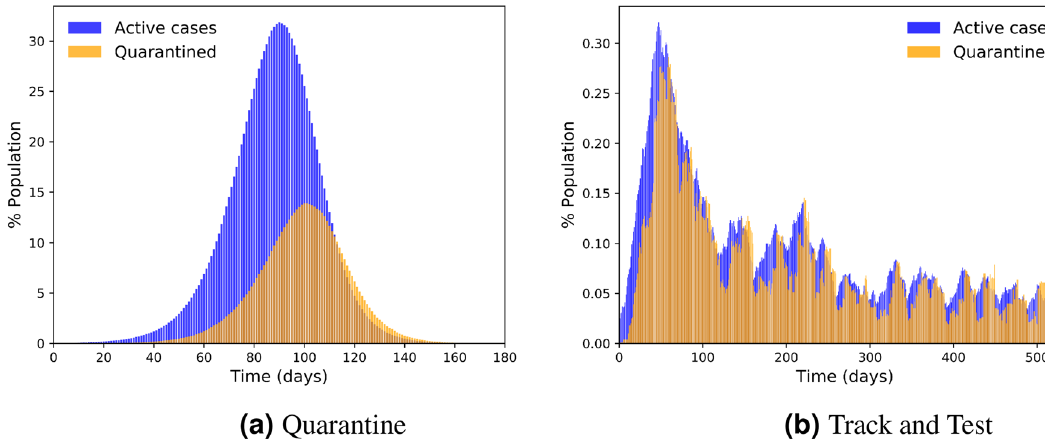
Figure 7. Active and quarantined cases.